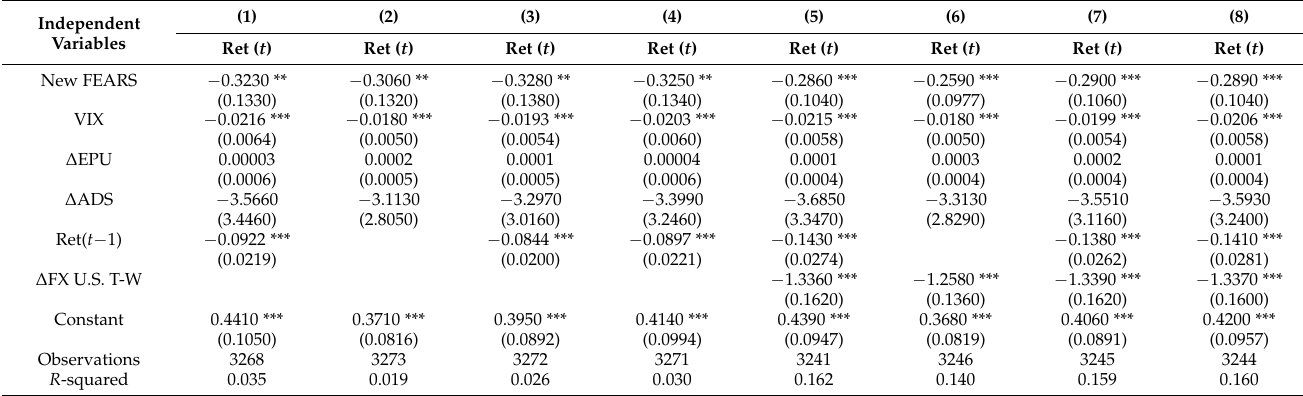
Table 7. New FEARS and the BNY ADR Index, estimated with Newey and West’s (1994) standard errors. Independent